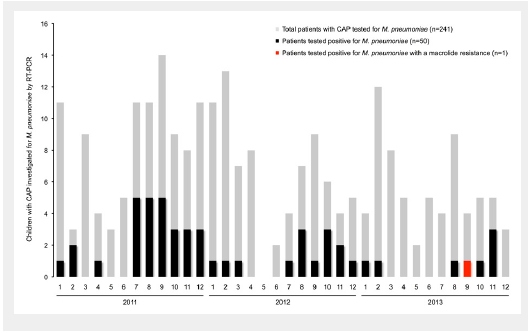
Case distribution of children with community-acquired pneumonia (CAP) investigated for Mycoplasma pneumoniae by real-time polymerase chain reaction (RT-PCR) in respiratory specimens (n = 241) during the study period between 2011 and